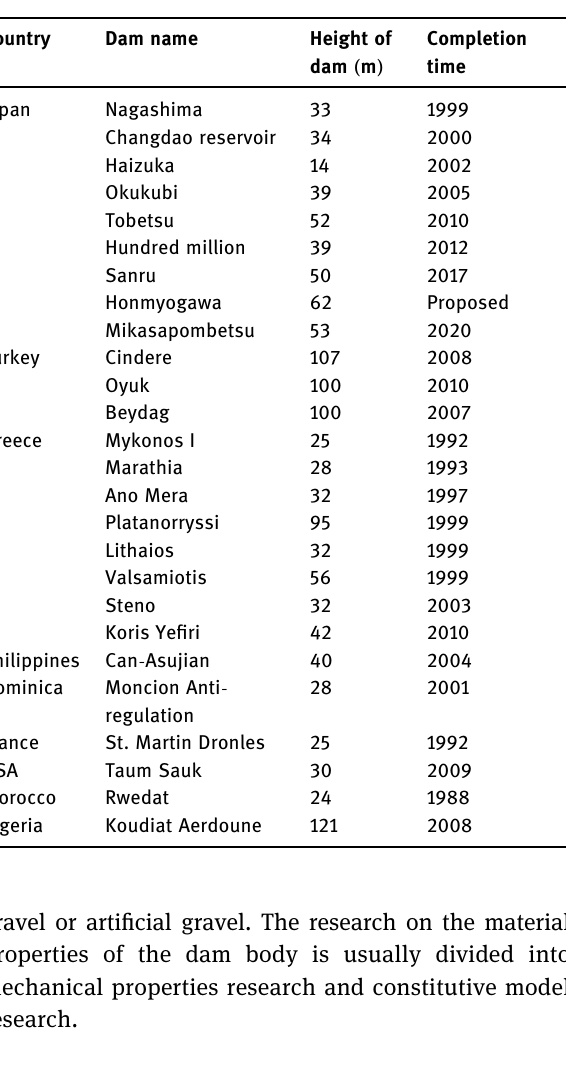
Table 1: Representative CSG projects abroad